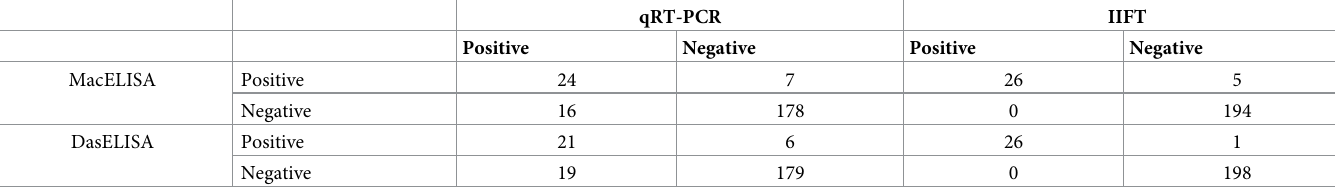
Table 4. Comparison of Mac-ELISA and Das-ELISA to qRT-PCR and IIFT in laboratory detection of CHIKV